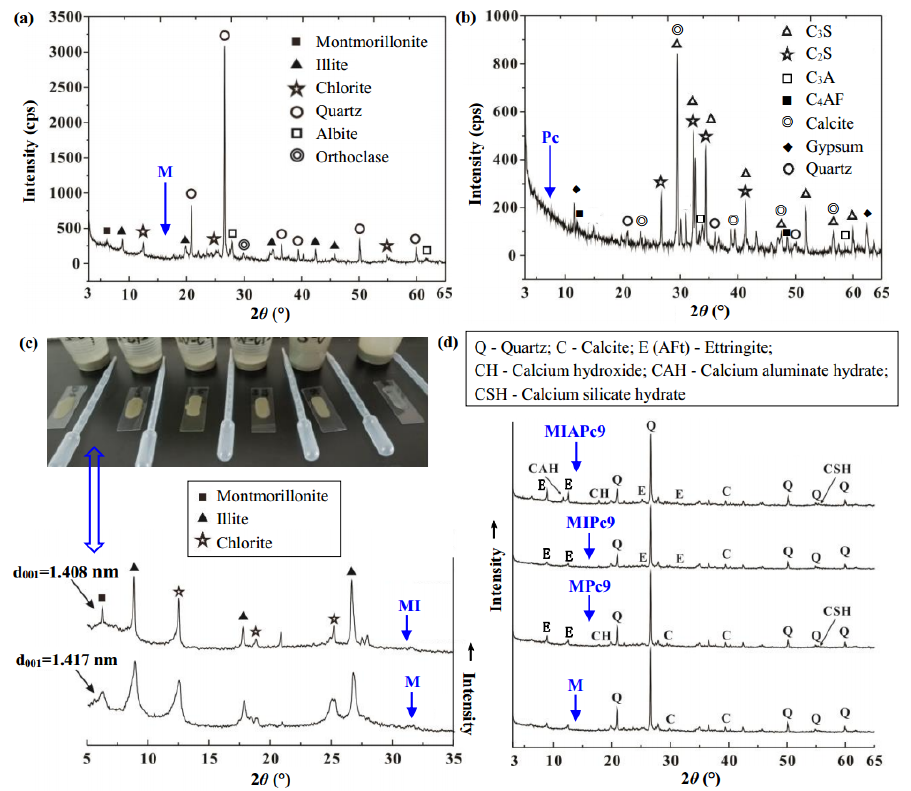
Figure 10. XRD patterns: ( a ) XRD of natural Ningde marine muck; ( b ) XRD of Portland cement; ( c ) XRD samples prepared on oriented sheet and XRD patterns of directional samples; ( d ) XRD patterns of nondirectional